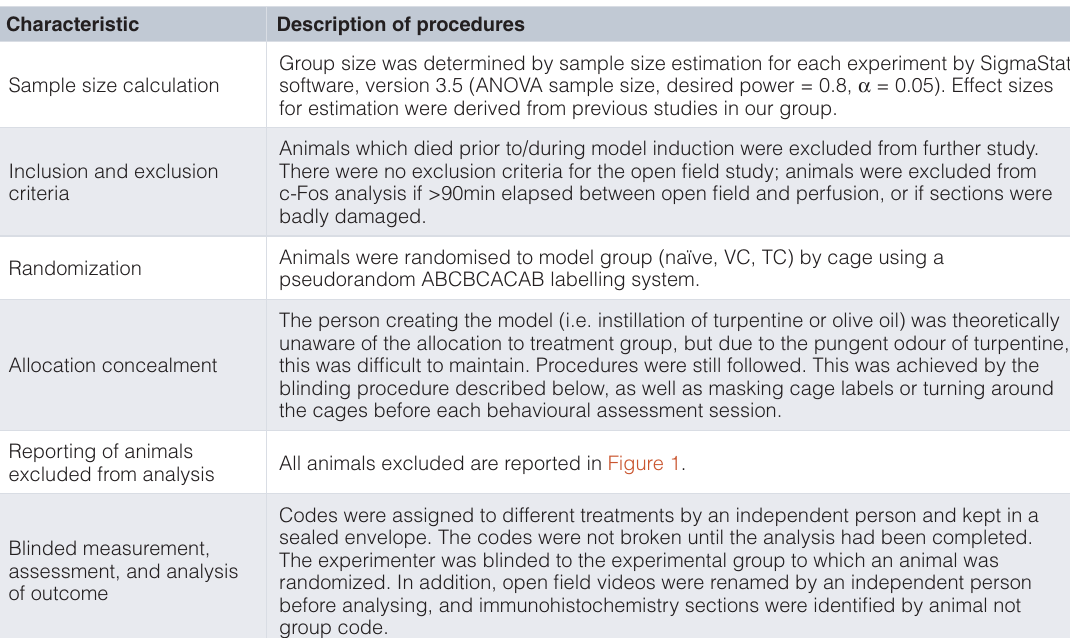
Table 1. Major Domains of Good Laboratory Practice (after Macleod et al. ,